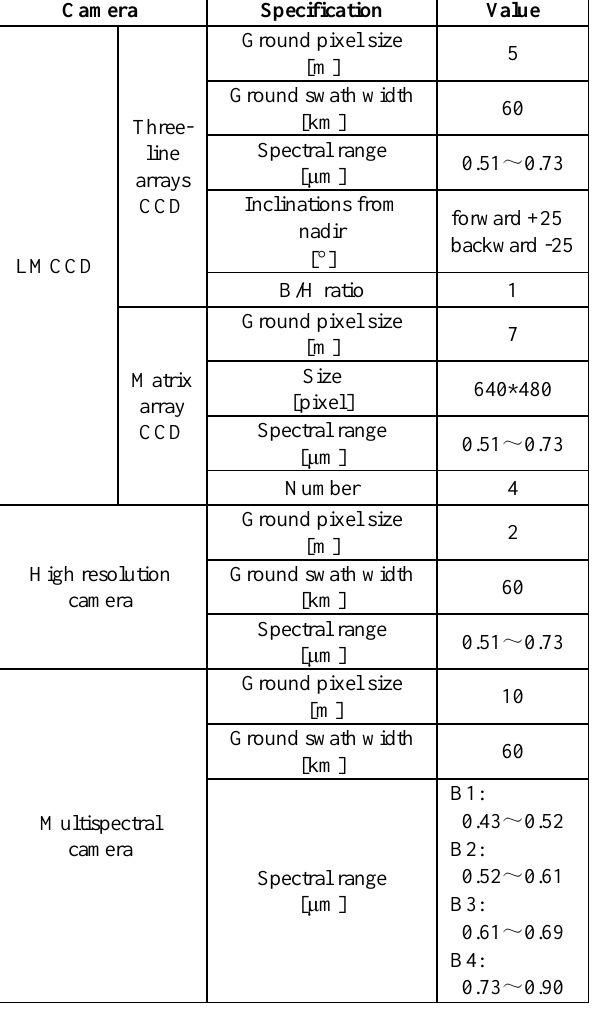
Table 1. The camera parameters of TH-1